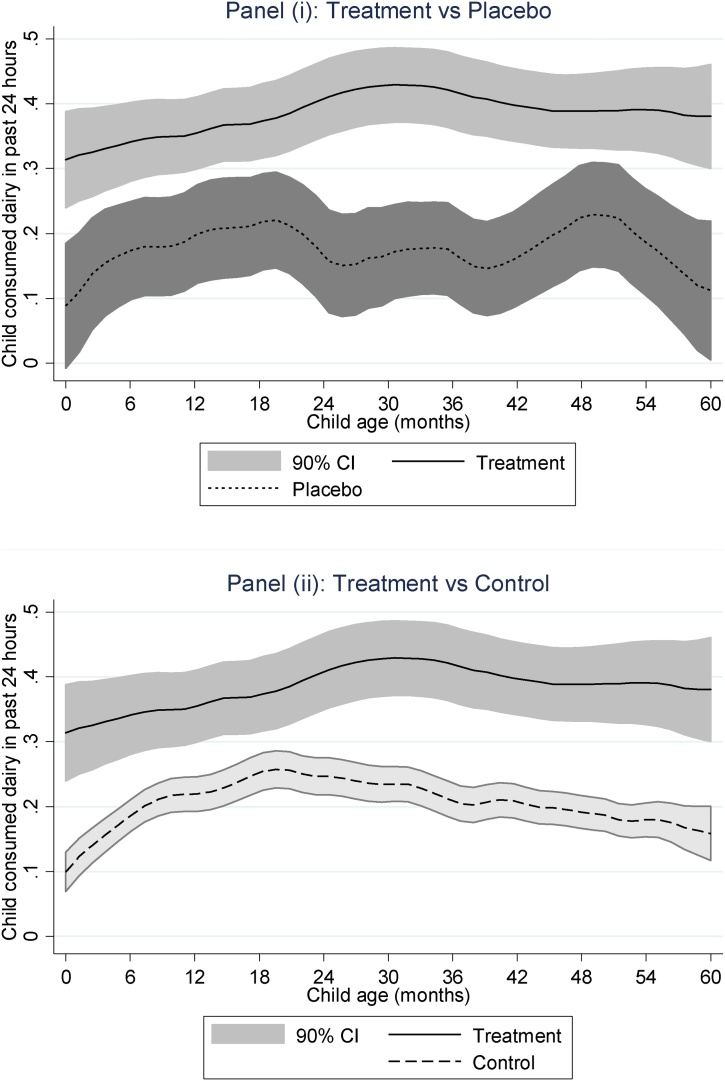
Local polynomial smoothing estimates of dairy consumption against child age by treatment group, with 90% confidence intervals.